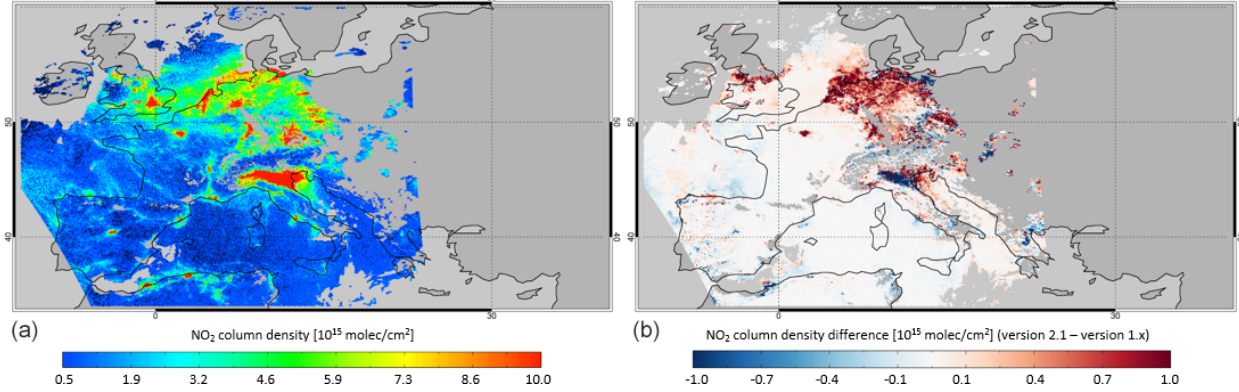
Figure 15. Tropospheric NO 2 columns retrieved using the OCRA/ROCINN cloud parameters from the version 2.1 processor (a) and differ- ences with version 1.x (b) over Europe for orbit 6939 on 14 February 2019. Only measurements with a cloud radiance fraction less than 0.5 are